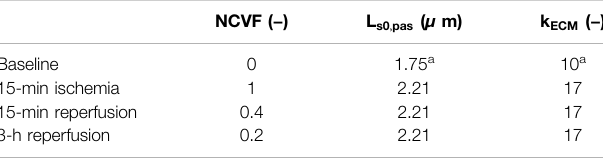
TABLE 2 | Calibrated parameter values for the simulations of acute ischemia and reperfusion. NCVF ( − ) L s0 , pas ( μ